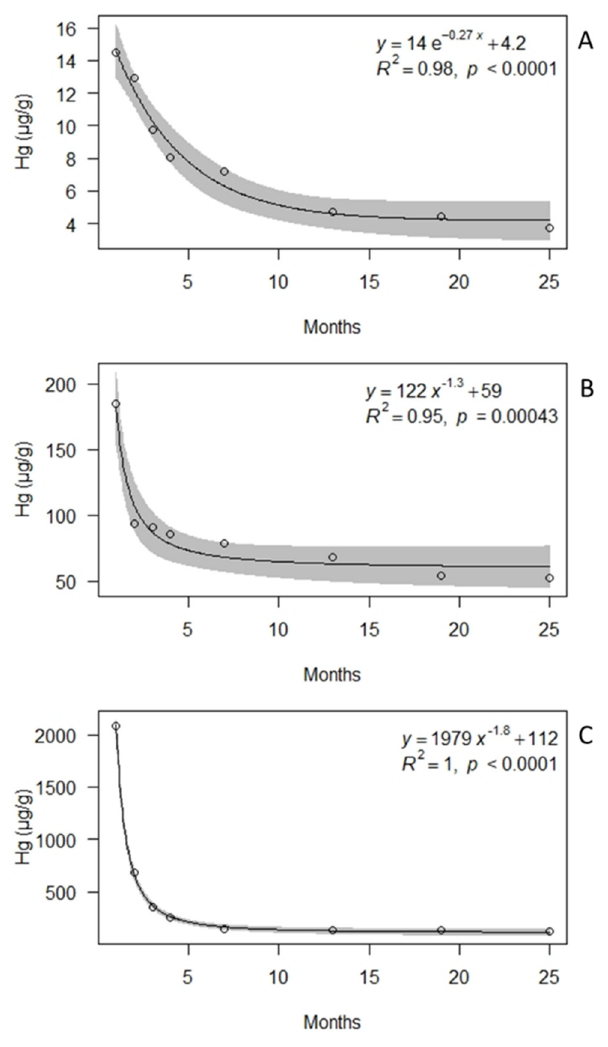
Figure 4. Exponential and power regression of mean Hg concentrations (µg/g) over time in samples of the lichen Evernia prunastri incubated with 1 ( A ), 10 ( B ), and 100 ( C ) µM Hg 2+ solutions and transplanted for 1, 2, 3, 6, 12, 18, and 24 months at the Botanical Garden of the University of Siena. Gray area = 95% confidence interval.